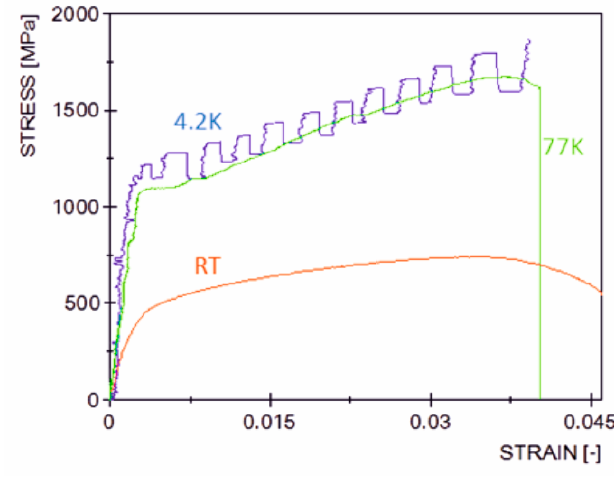
Figure 3. Stress versus strain for flat specimens with symmetrical notches.